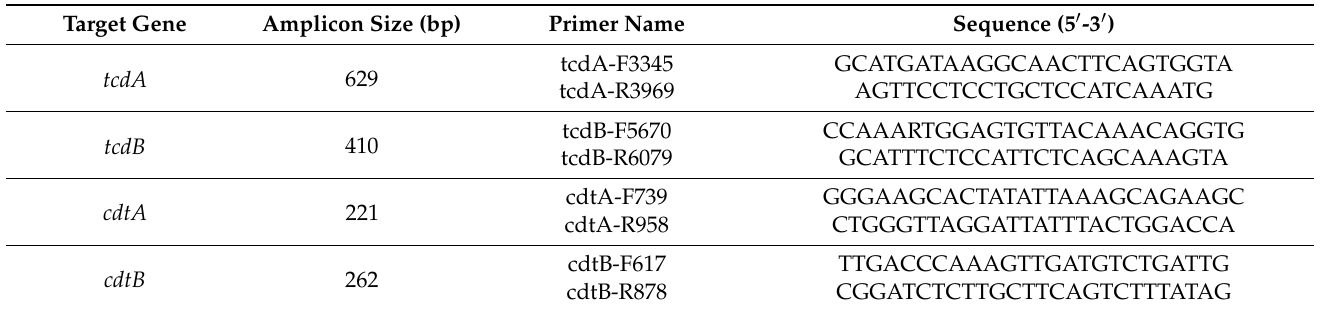
Table 6. Primers for detection of toxin-encoding genes of C. difficile